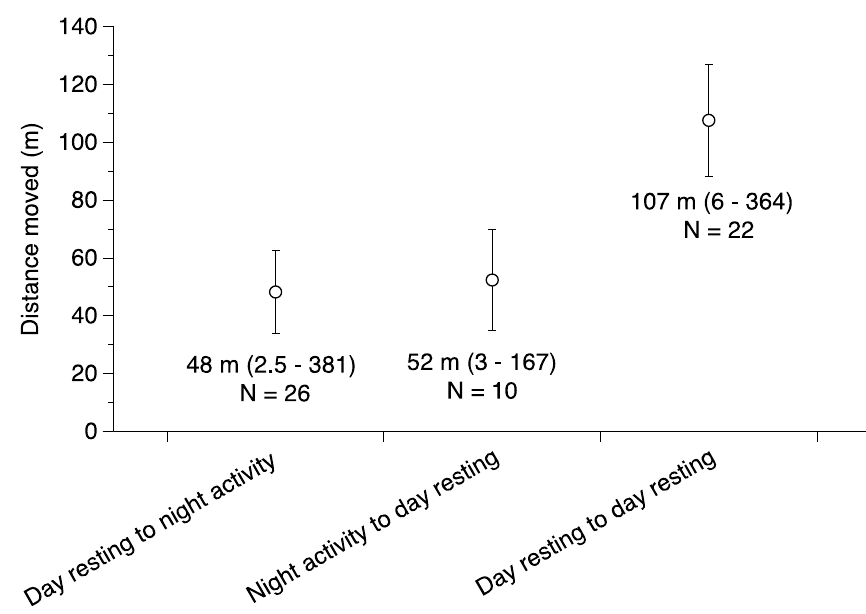
Figure 4. Mean movement distances of telemetered scrub pythons ( Simalia amethistina ) from daytime resting sites to nocturnal hunting sites and back again. Means and movement ranges are provided below each data